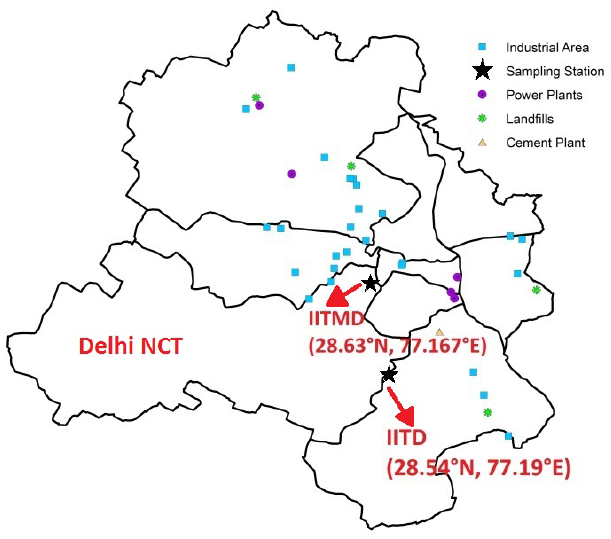
Figure 1. Sampling sites with various emission sources like power plants, industries, landfills,